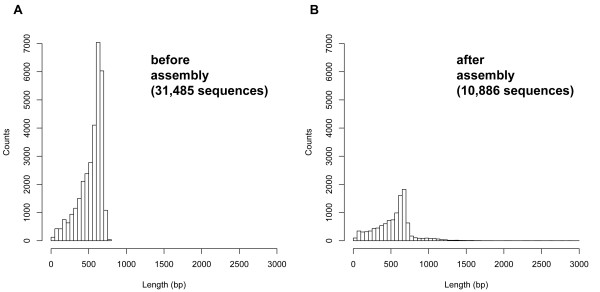
Length distribution of H. bacteriophora ESTs before and after assembly.